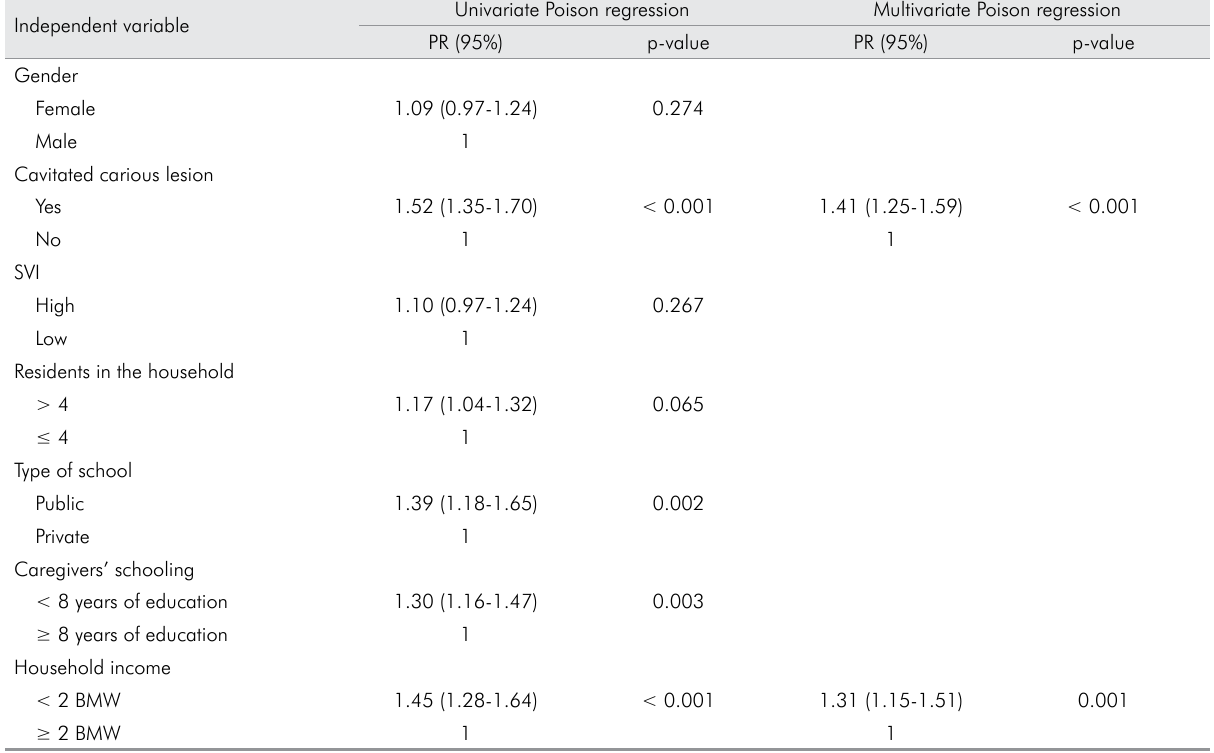
Table 2. Univariate and multivariate Poison regressions explaining the influence of independent variables on the high impact on OHRQoL. Independent